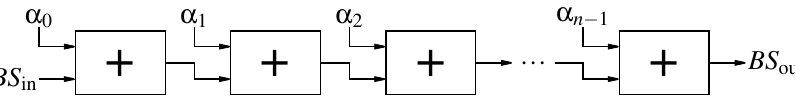
Figure 7. Scaling based on Delta Adder, where α i is the i th bit from the MSB